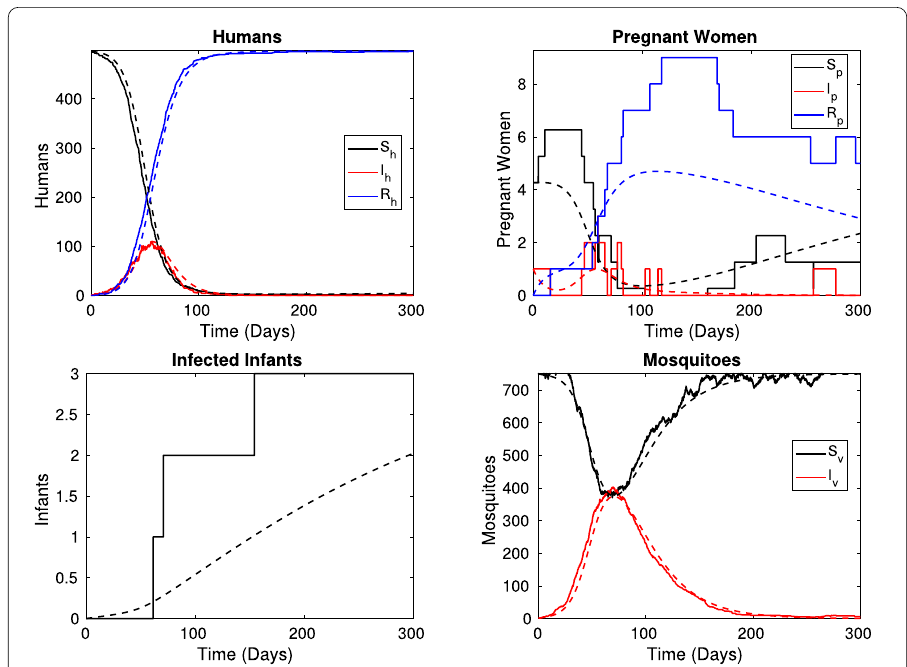
Figure 2 Comparison of one sample path of the CTMC dynamics (solid line) and the ODE dynamics (dashed line). Parameter values are taken from Table 3 for given initial conditions S h (0) = 994, I h (0) = 1, R h (0) = 0, S p (0) = 4, I p (0) = 1, R p (0) = 0, B (0) = 0, S v (0) = 749, and I v (0) = 1. The probability of disease extinction is P 0 = 0.0368.